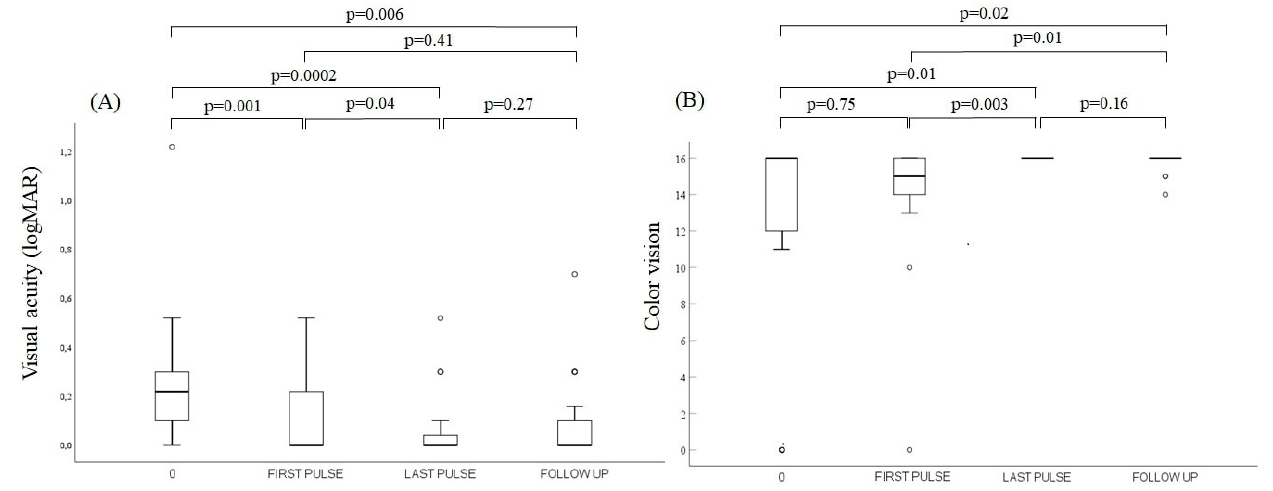
Figure 1. Comparison of variables during the treatment at three time points: 0, FIRST PULSE and LAST PULSE ( n = 26) and after the treatment at FOLLOW UP ( n = 22). ( A ) Visual acuity (logMAR). ( B ) Color vision. Vertical line ranges from maximum to minimum value. Data are shown as median values (line across the box) with interquartile (25th–75th percentile) range (the box). Bullets represent the outliers. Abbreviations: logMAR, logarithm of the minimum angle of resolution; 0, diagnosis of dysthyroid optic neuropathy; FIRST PULSE and LAST PULSE, before and after the additional treatment with intravenous methylprednisolone pulses, respectively; FOLLOW UP, post treatment evaluation after median time of 4.5 months.